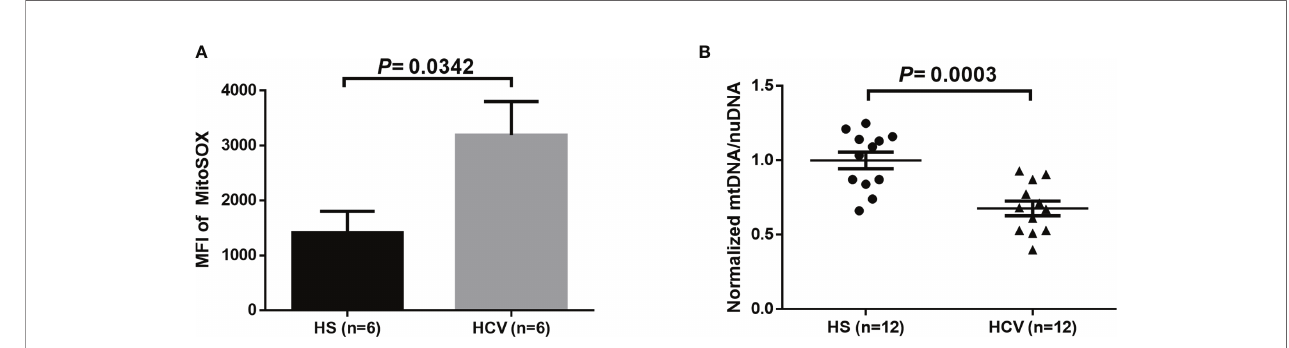
FIGURE 2 | Mitochondrial-speci fi c ROS and mitochondrial DNA (mtDNA) copy number in TCR-stimulated CD4 T cells from HCV-infected individuals and HS. (A) Flow cytometry analysis of the MFI of MitoSOX in TCR-stimulated CD4 T cells from HCV-infected individuals and health subjects (HS). (B) Quanti fi cation of mitochondrial DNA (mtDNA)/nuclear DNA (nuDNA) content in TCR-stimulated CD4 T cells from HCV-infected individuals, normalized to HS. The data were analyzed by parametric